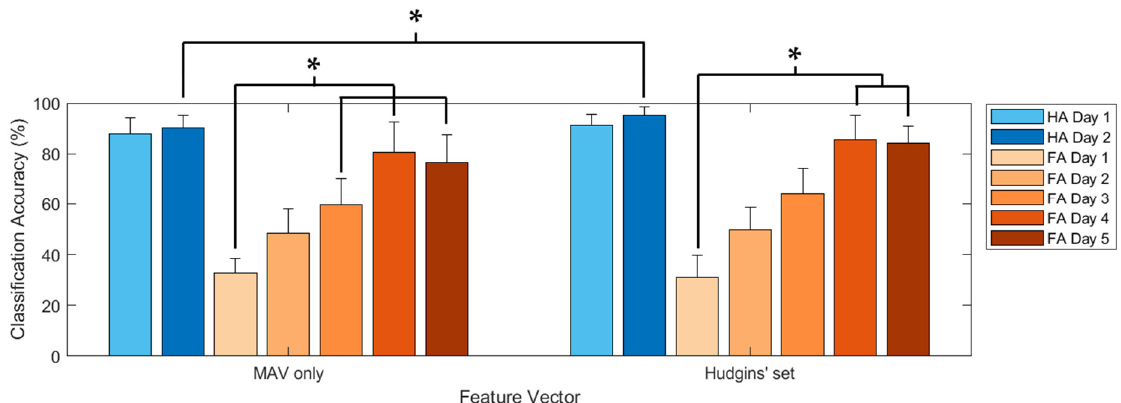
Figure 9. Classification accuracy according to the feature vectors and visual feedback training (*: p < 0.05).